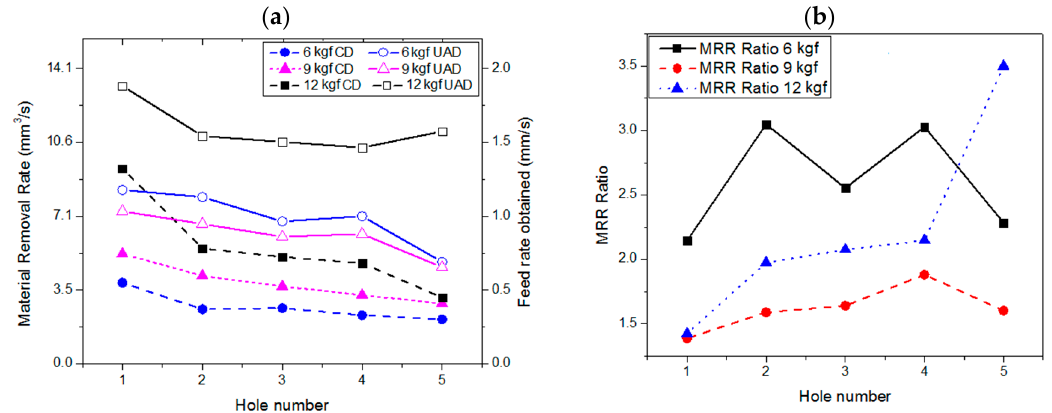
Figure 7. ( a ) Material removal rate (MRR) and ( b ) MRR ratios at different axial force levels. A higher ratio means a higher MRR of UAD compared with that of CD.